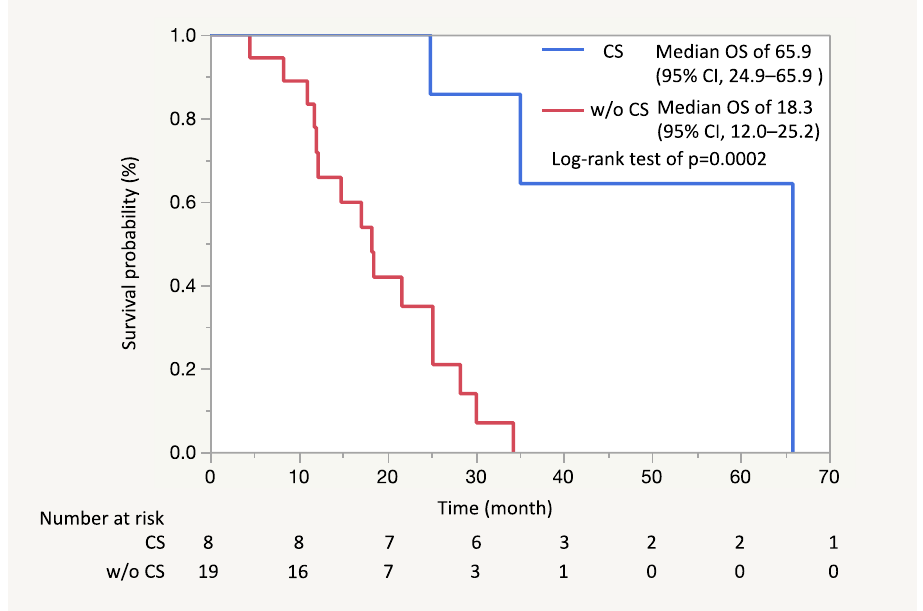
Figure 3. In Kaplan-Meier analysis, the median overall survival (OS) in the patients who underwent conversion surgery was estimated as 65.9 months (95% CI, 24.9–95.9) and was significantly longer than that in the patients who had the best response of partial response but did not have conversion surgery (median OS of 18.3 months; 95% CI, 12.0–25.2) (Log-Rand test of p = 0.0002).